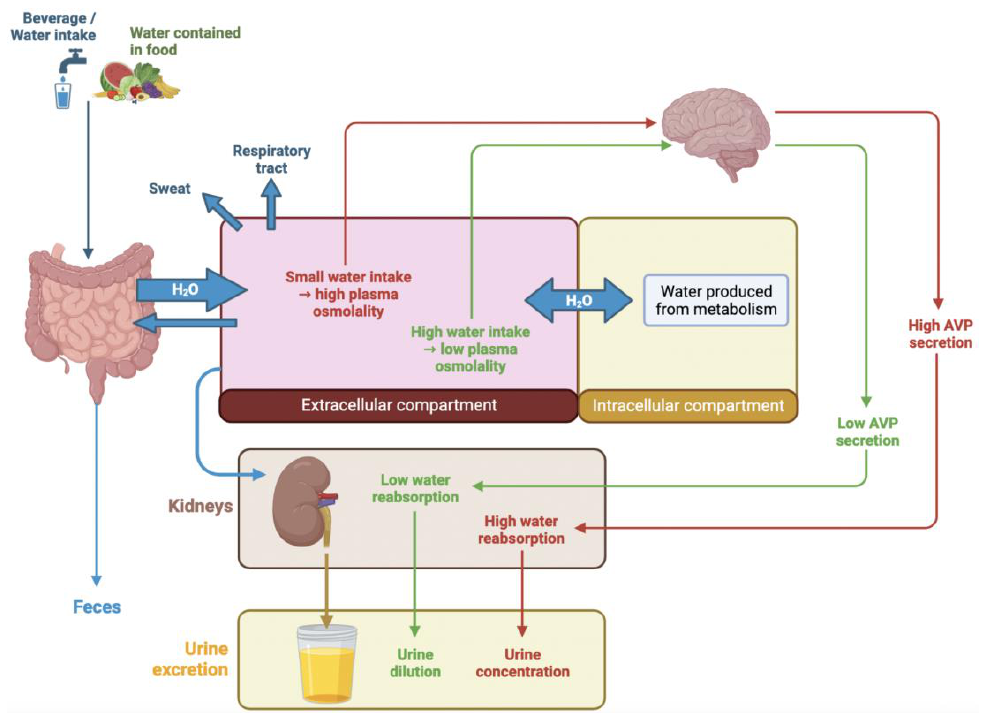
Figure 1. Physiological regulation of water balance. Fluid intake is mostly excreted by kidneys in response to water balance and AVP release. In the case of limited water intake (red arrows), intracellular volume decreased, leading to high AVP release and thus maximum water reabsorption by the kidney. Finally, a small amount of concentrated urine is excreted. On the other hand, high fluid intake (green arrows) leads to increased intracellular volume and thus to suppression of AVP release, and finally an increased amount of diluted urine.